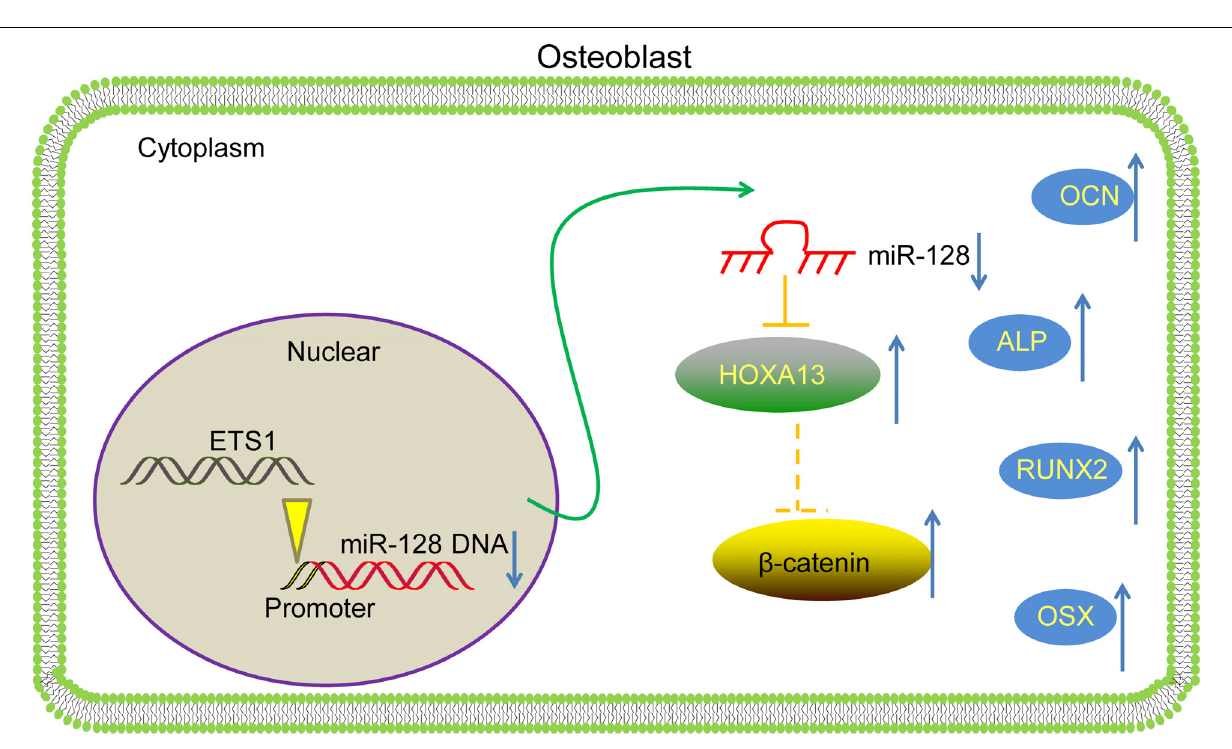
Frontiers in Physiology |